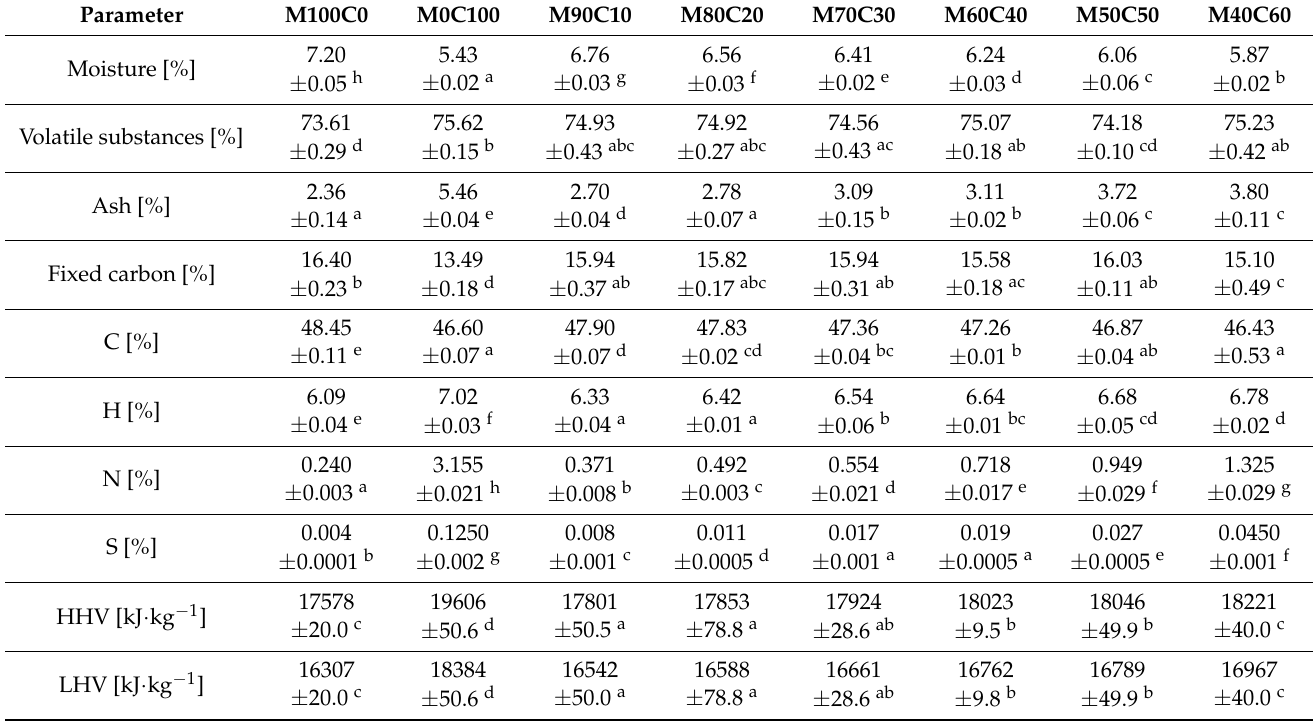
Table 1. Results of proximate and ultimate analysis and heating value